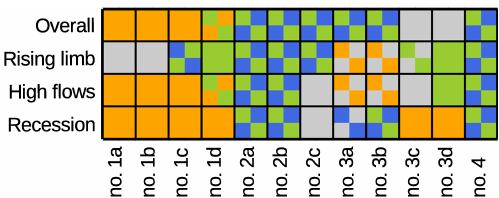
Figure 9. Summary of the models’ benchmark. A colour is at- tributed for each score and each catchment when one model gives a clearly superior performance, or two colours are attributed for each score and each catchment when two models give clearly superior performances: the score of a model is defined as clearly superior when the lower bound of its confidence interval is higher than the median values obtained with the other models. The superiority of a model might be half attributed if the criteria is only respected for the calibration processes. Colour attribution: orange for the DWF model, blue for the SSF model, green for the SSF-DWF model and grey when the superiority of one’s model is